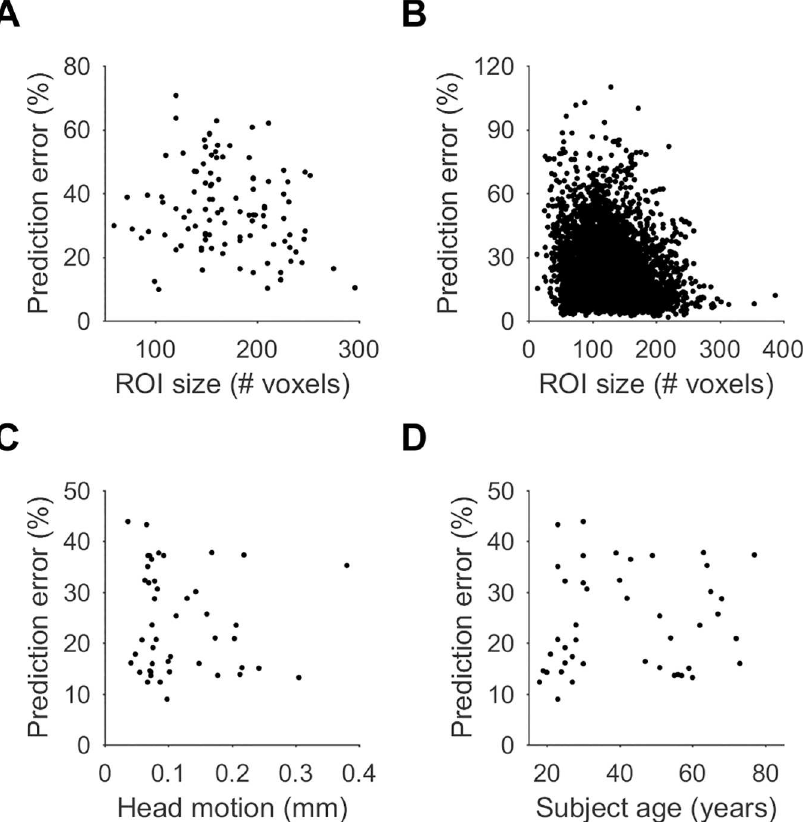
Fig 7. Prediction error did not depend on ROI size, head motion or subject age. A, B. Prediction error of ROIs was only weaklycorrelatedwith the ROI size, both in singlesubjects ( A , r = -0.19, n = 104 cortical ROIs) and across subjects( B , r = -0.2, n = 4,784 cortical ROIs). C. Average predictionerror was not correlatedwith subject head motion ( r = -0.09, p = 0.56). D. Average predictionerror was not correlatedwith subject age ( r = -0.1, p =